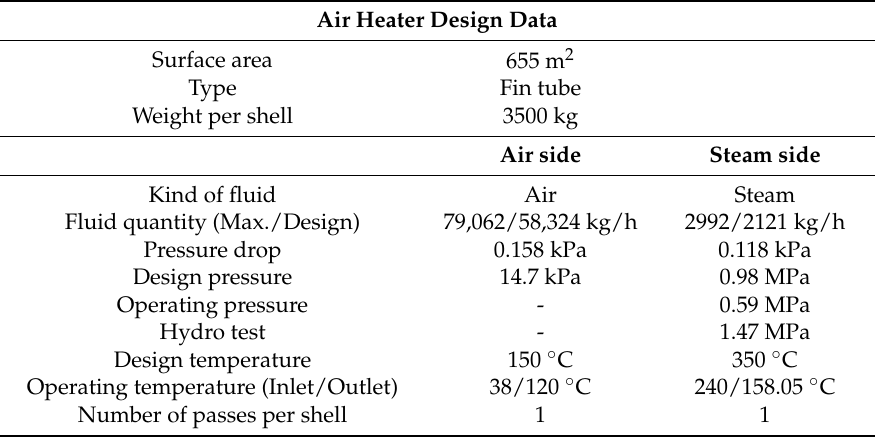
Table 1. Analyzed steam air heater design data.